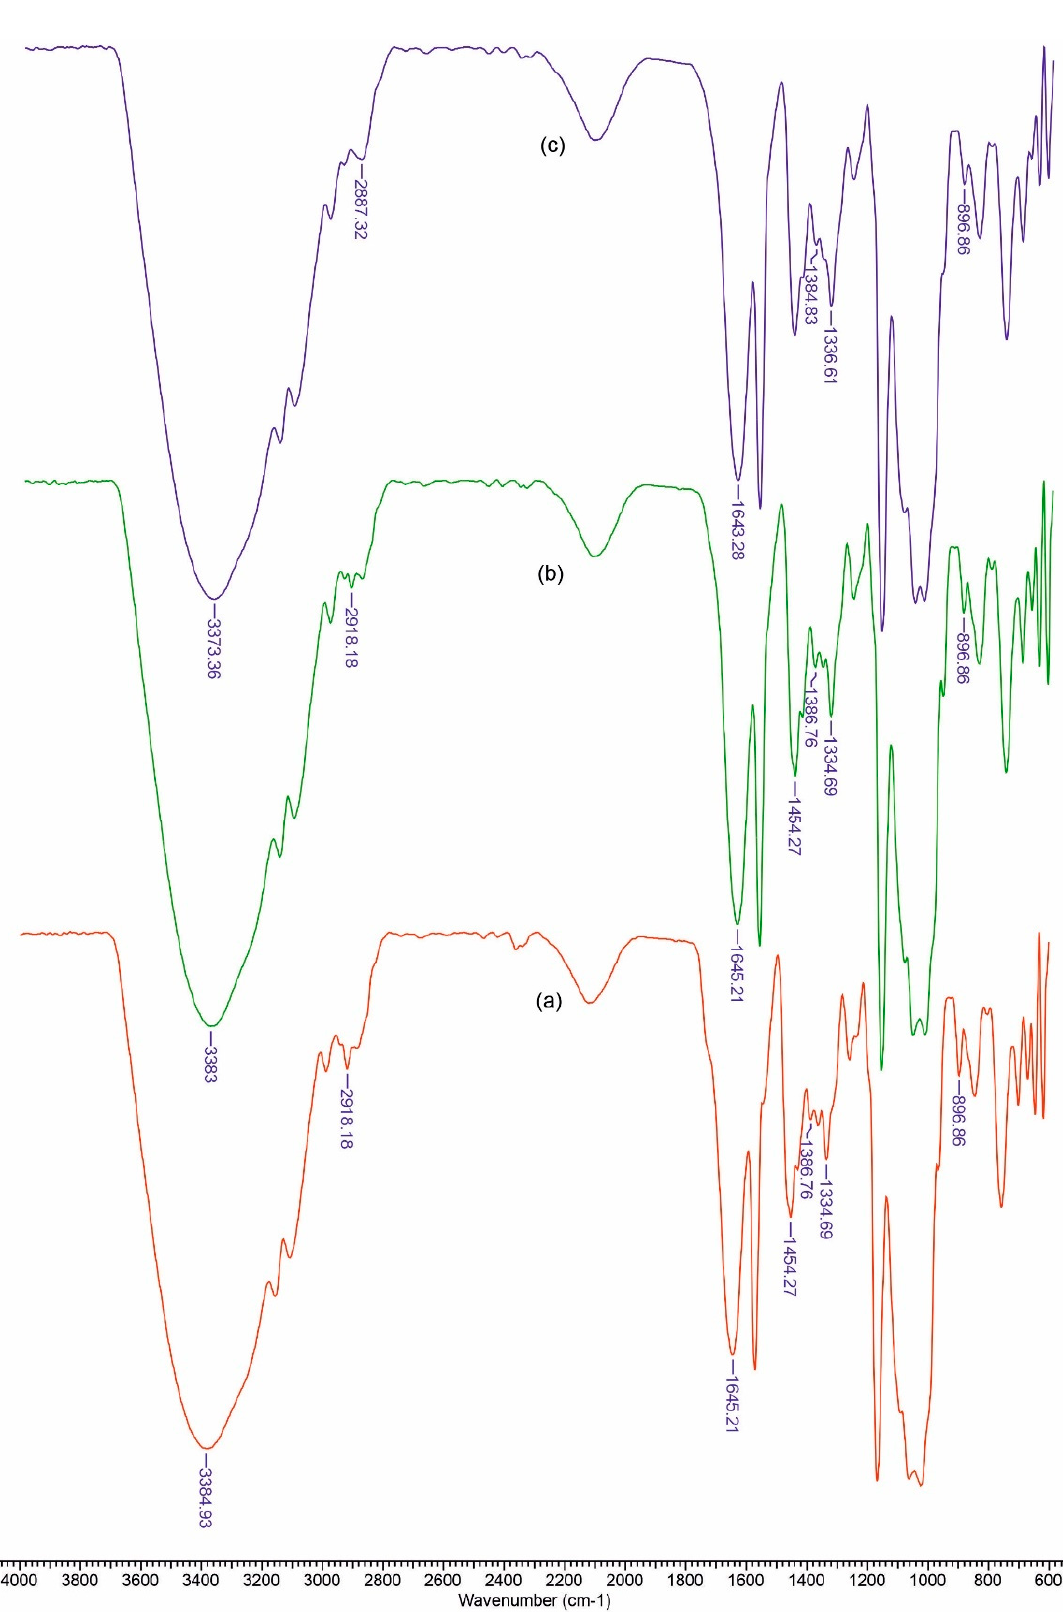
Figure 3. FTIR spectra for CCPLMCK( a ), CCPOL ( b ) and CCP ( c ).